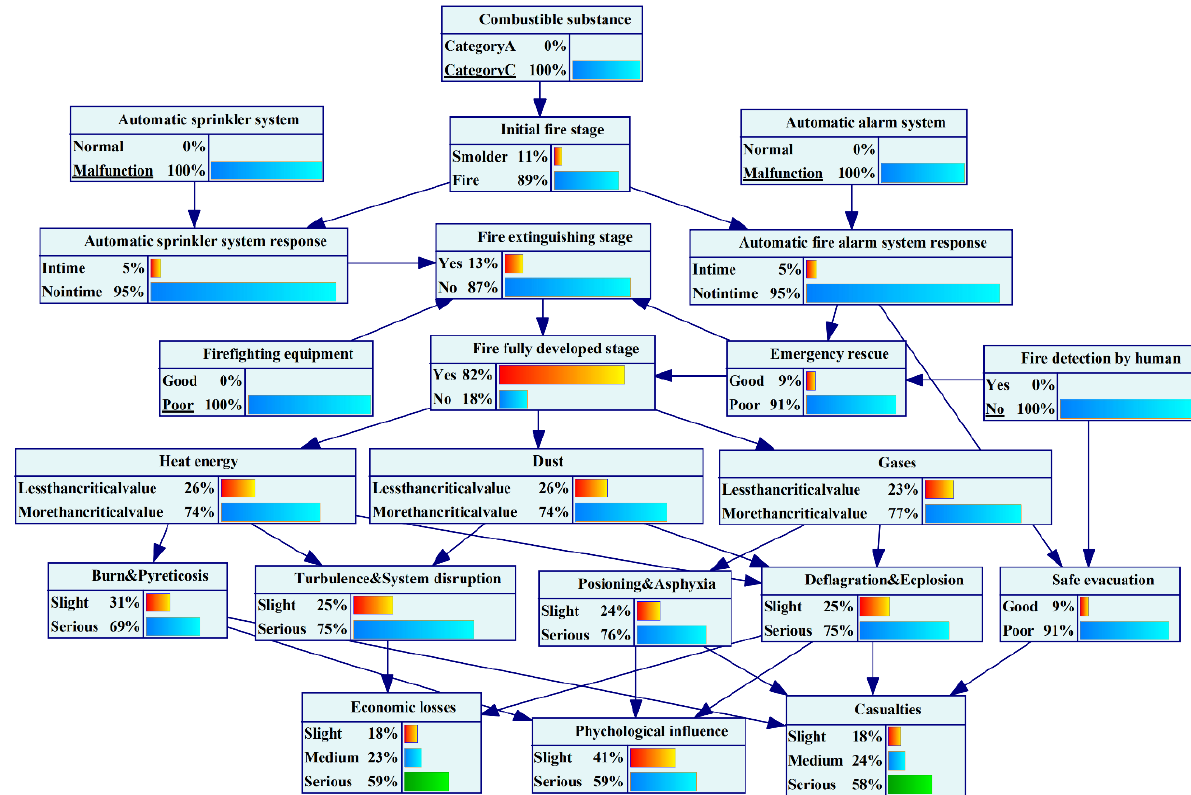
Figure 13. Scenario results with poor fire safety barriers.